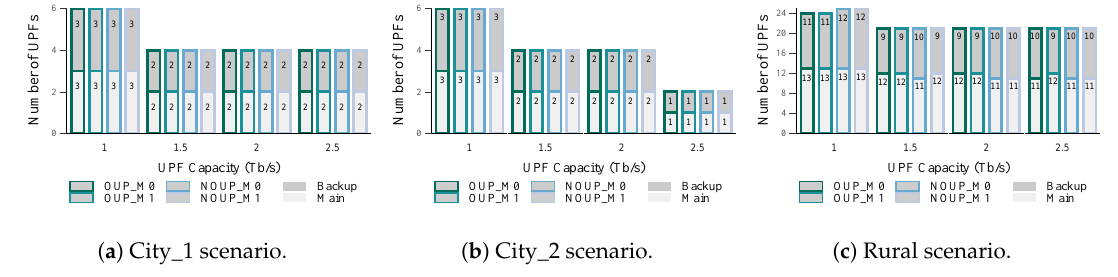
Figure 5. Number of UPFs vs. capacity for services with high requirements.